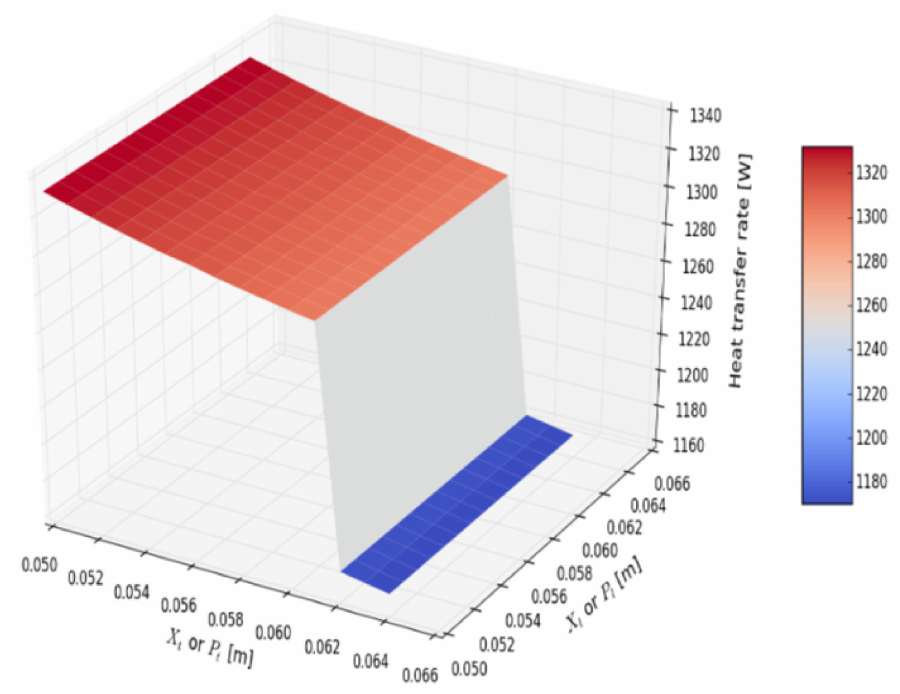
Figure 16. Heat transfer rate vs. traversal and longitudinal spacing of the tubes.